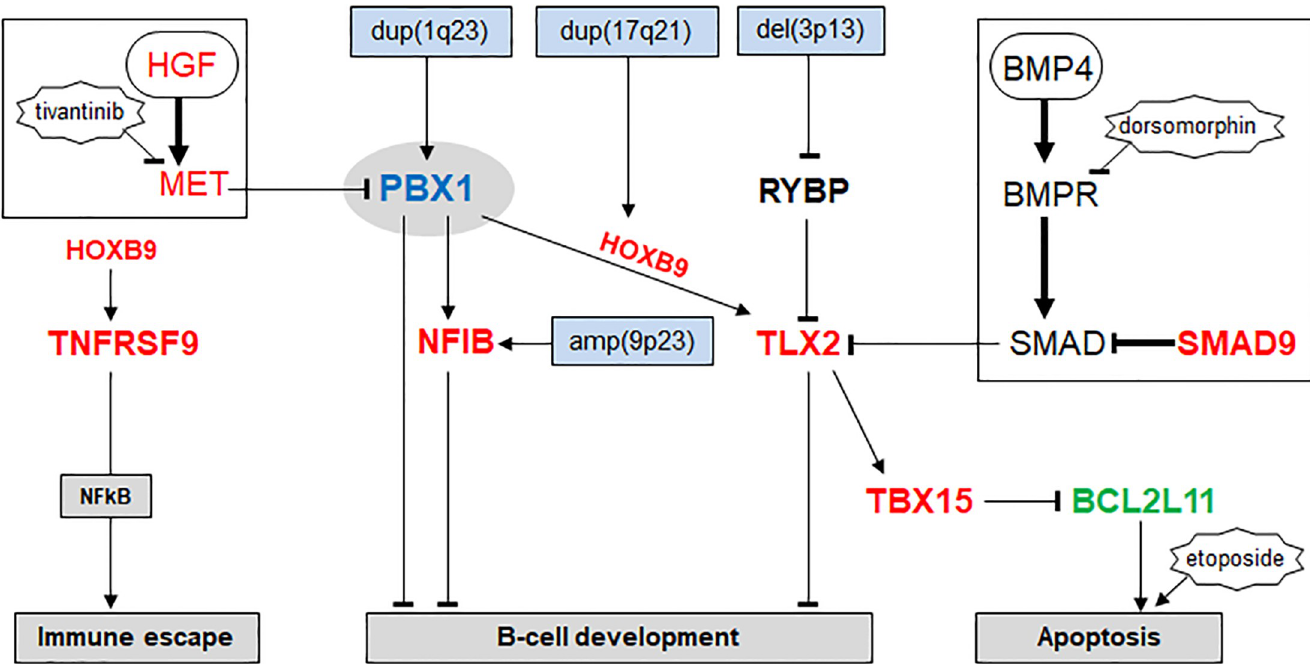
Fig 7. Gene regulatory network around PBX1 in HL. This diagram summarizes the results of the study. Chromosomal rearrangements (blue boxes) deregulate PBX1, RYBP and NFIB. PBX1 activates NFIB and TLX2 but not TNFRSF9. HOXB9 activates TNFRSF9 without PBX1, and TLX2 in cooperation with PBX1. TBX15 is a target gene of TLX2 and inhibits pro-apoptotic gene BCL2L11. HGF-signalling inhibits PBX1 and BMP-signalling inhibits TLX2 expression (both pathways are in black boxes). SMAD9 operates as inhibitor of the BMP-pathway.